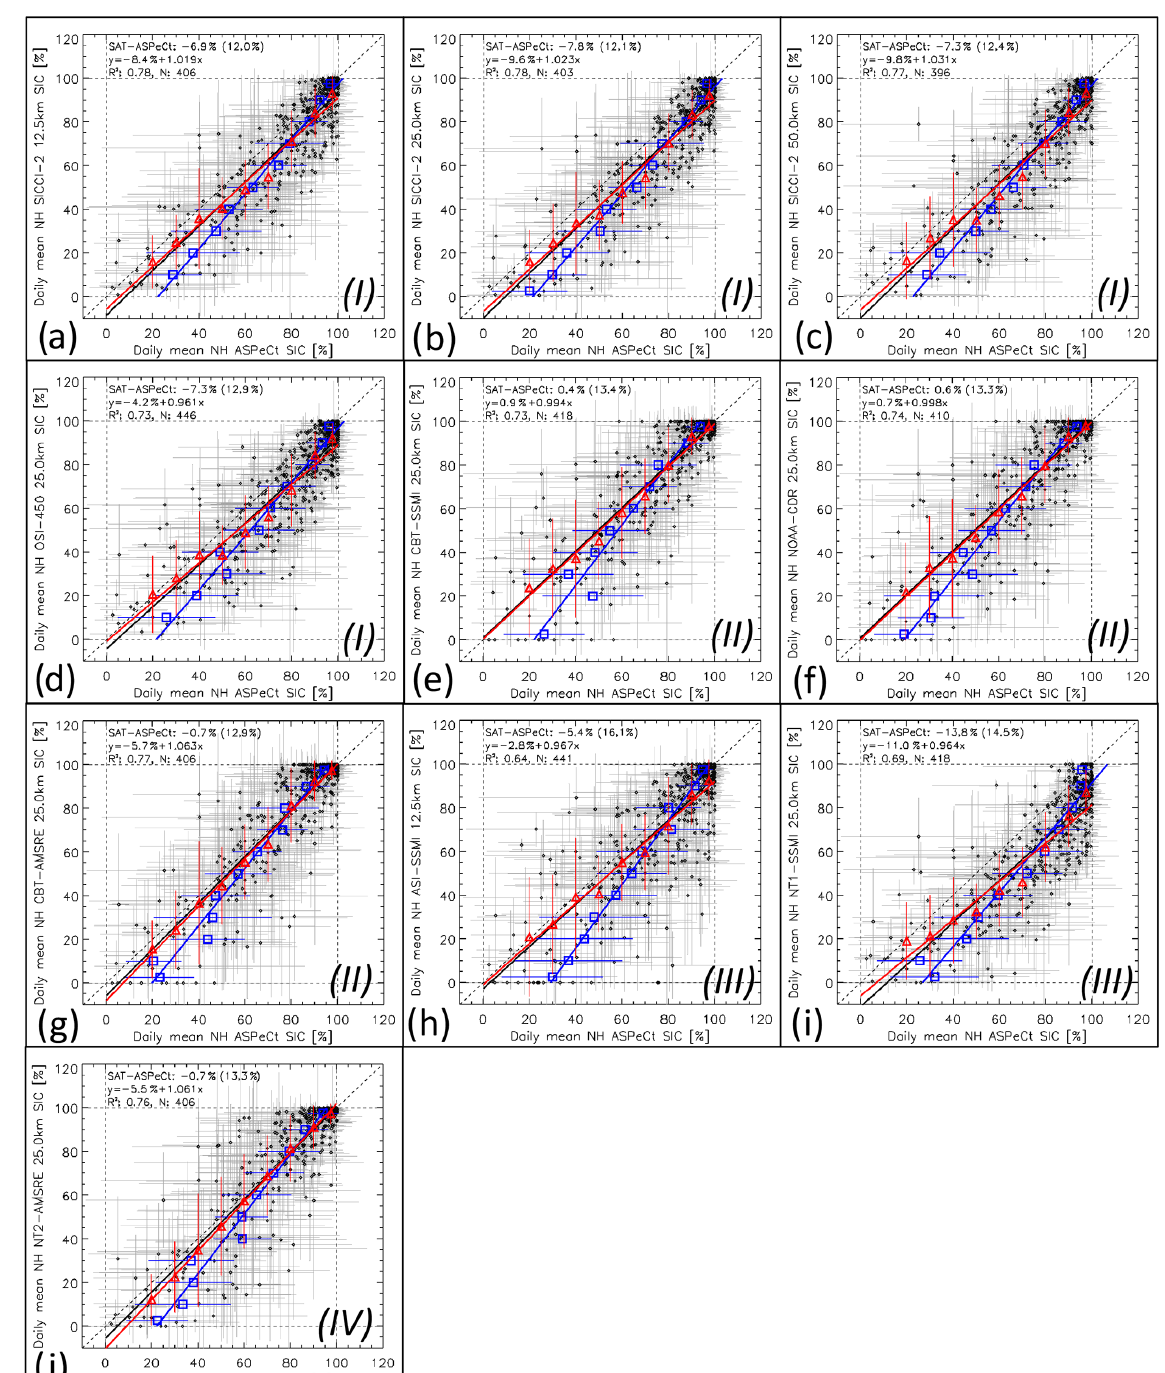
Figure 15. Scatterplots of co-located daily average SIC from visual ship-based observations (ASPeCt, x axis; note that these are Ice Watch/ASSIST for the Arctic) and the 10 satellite SIC algorithm products (SAT, y axes) for the Arctic during the years 2002–2011. Red symbols denote the average satellite SIC binned into 10% ASPeCt SIC intervals (except 0% ... 5% and 95% ... 100%, where 5% bins are used). Blue symbols denote the average ASPeCt SIC binned into 10% satellite SIC intervals. Error bars denote 1 standard deviation of the average. Dotted lines denote the identity line. Solid lines denote the linear regression of the respective value pairs. The mean difference and the standard deviation, the linear regression equation, the number of valid data pairs ( N ), and the squared linear correlation coefficient ( R 2 ) are given in the top left of every image for the daily SIC values. Roman numbers I–IV denote the group assigned to the respective algorithm (see text for